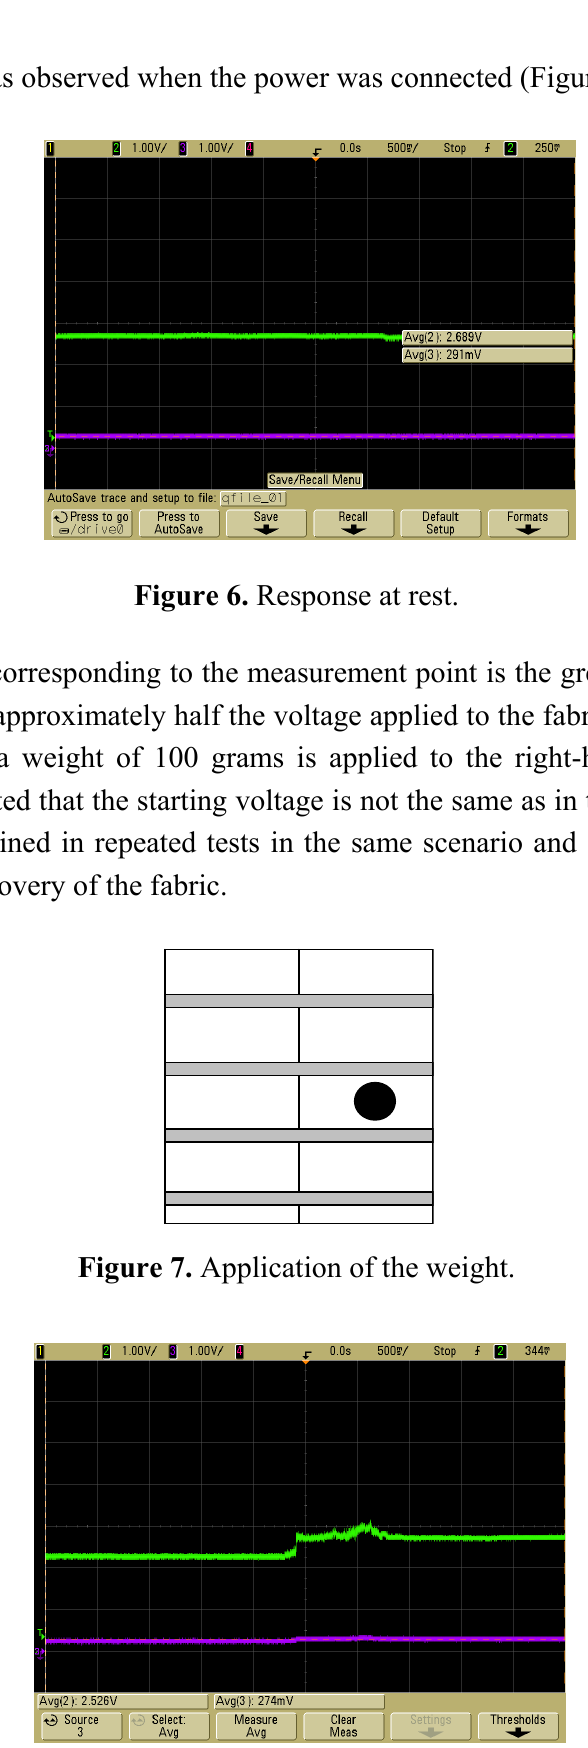
Figure 8. Response to the